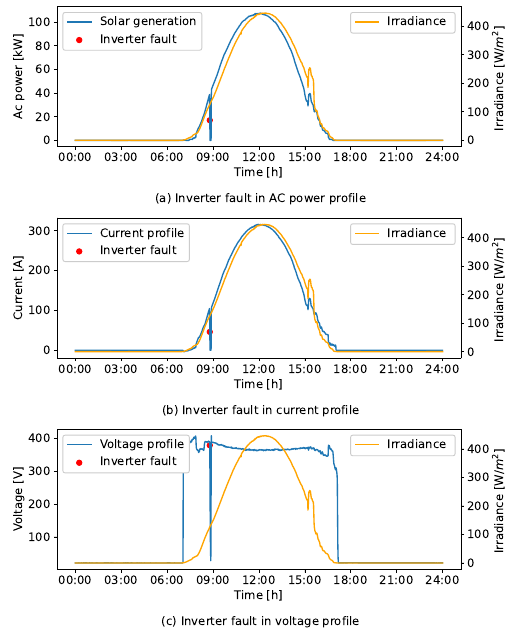
Figure 7. Typical inverter fault patterns observed in the NIST